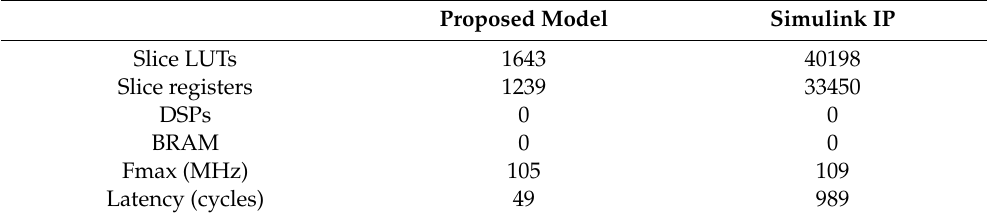
Table 2. Simulink accumulator resource usage, maximum frequency, and latency on Xilinx Artix 7.